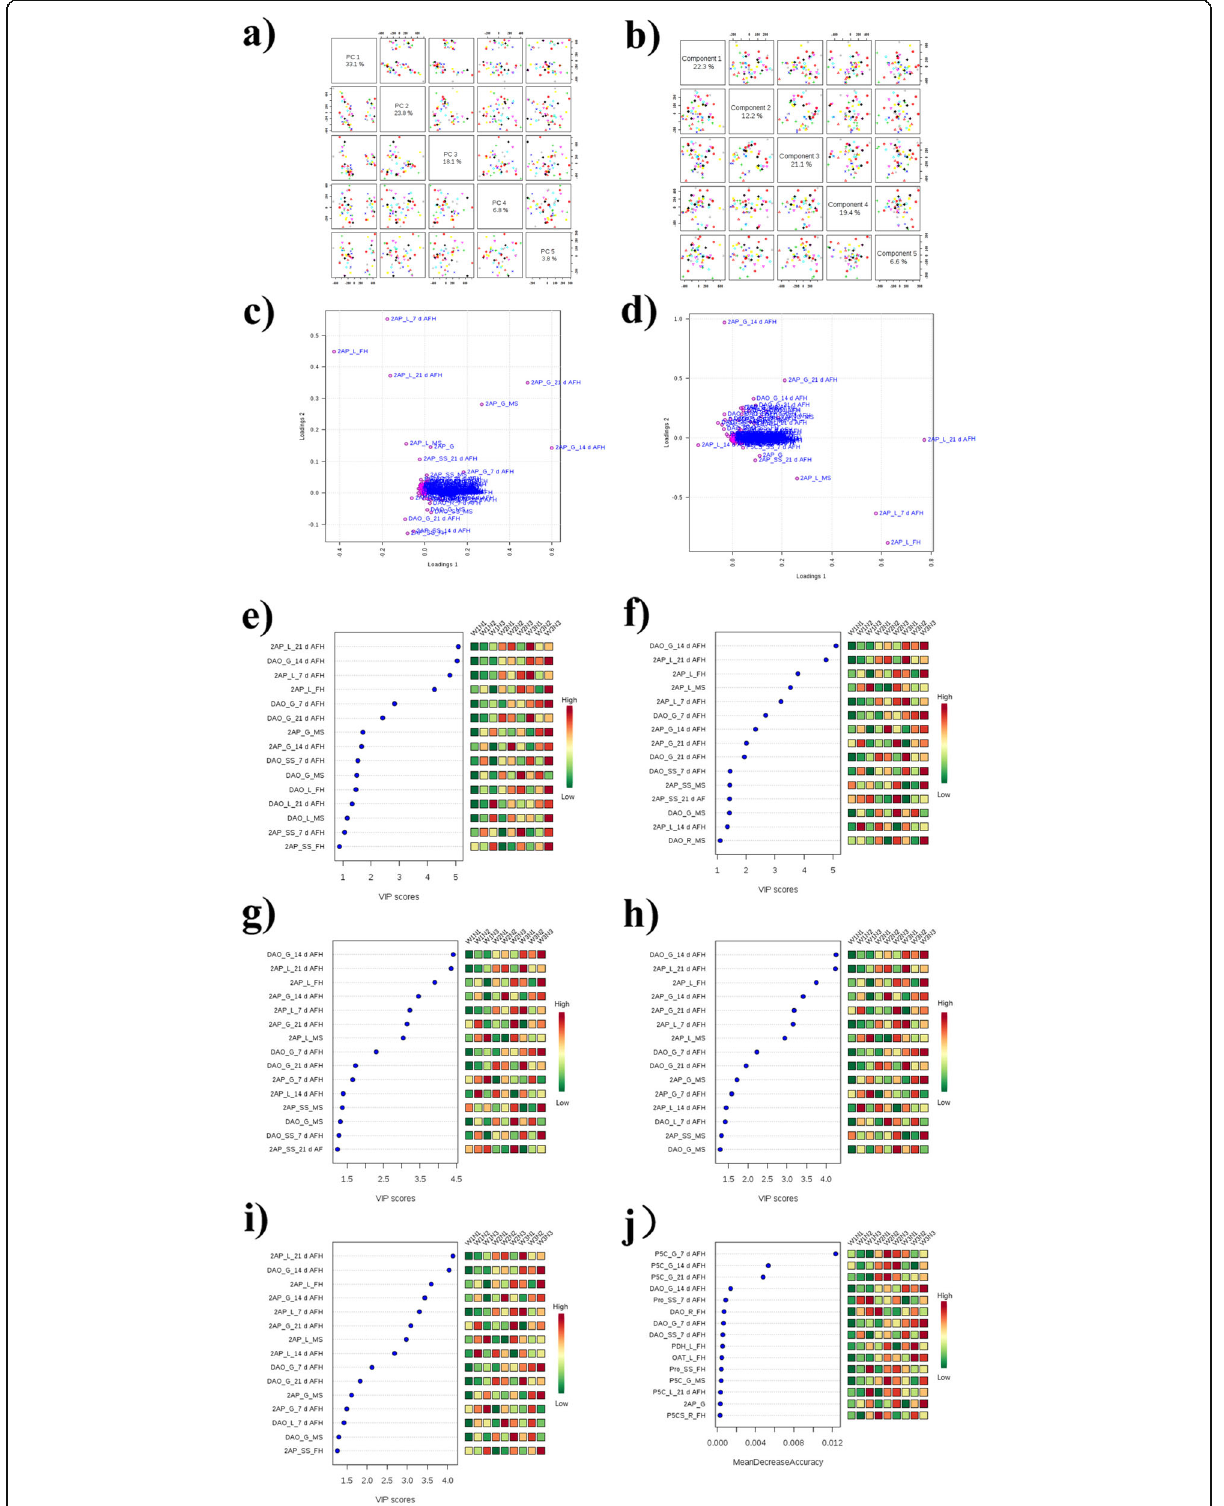
Fig. 4 PCA ( a and c ) and PLS-DA ( b and d ) analysis of the investigated parameters, the important features to the 5 components analysis of PLS- DA for different water and nitrogen treatment (component 1 – 5: e - i ) and the Parameters ranked by their contributions to classification accuracy (Mean Dicrease Accuracy, j